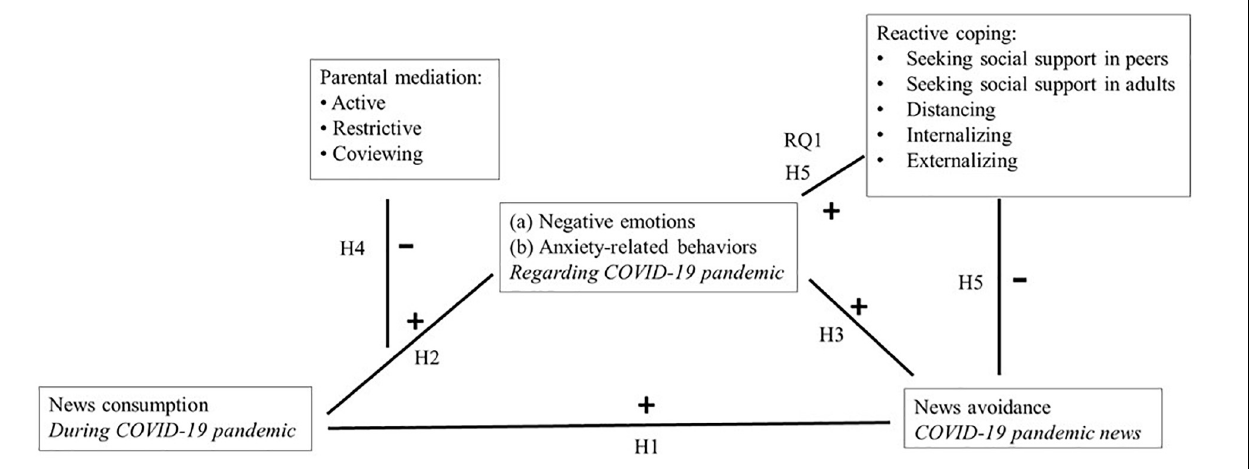
FIGURE 1 | Conceptual